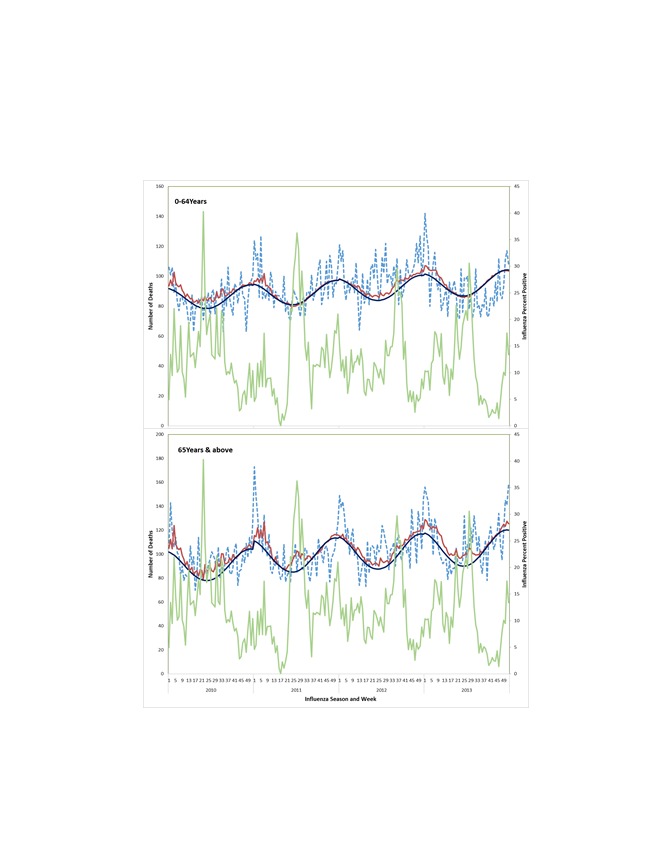
Observed circulatory deaths and predicted inﬂuenza-associated circulatory deaths and proportion positive for influenza viruses by age group, week, and year. The dotted blue line represents circulatory deaths, the green line represents influenza percent positive, the dark blue line represents expected baseline mortality, and the red line represents predicted mortality. Again, the influenza-associated excess circulatory deaths were the difference between the predicted circulatory mortality (ie, the orange line) and the baseline circulatory mortality (ie, the red line).